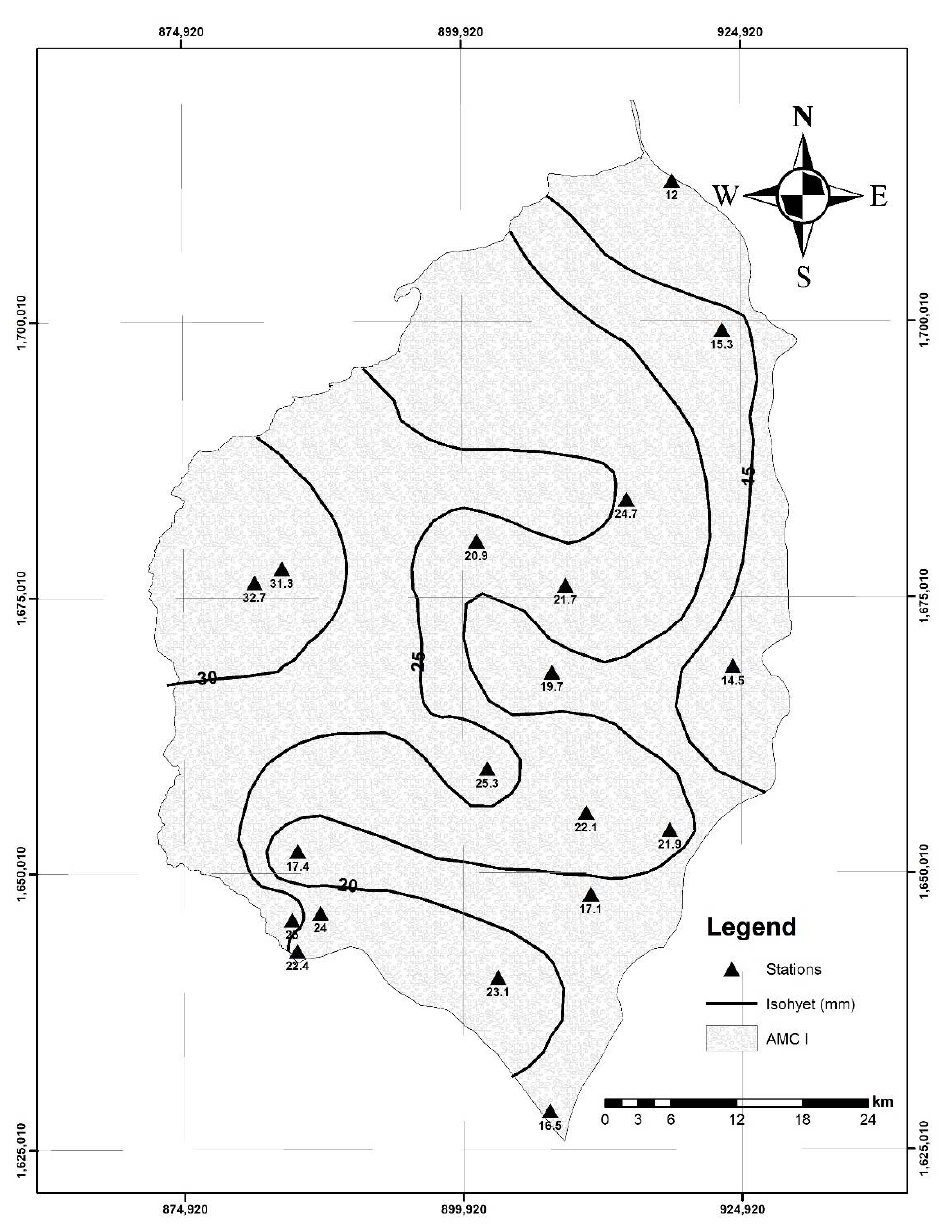
Figure 5. Spatial distribution of P prior-5d of the type of moisture conditions for a return period of 2.33